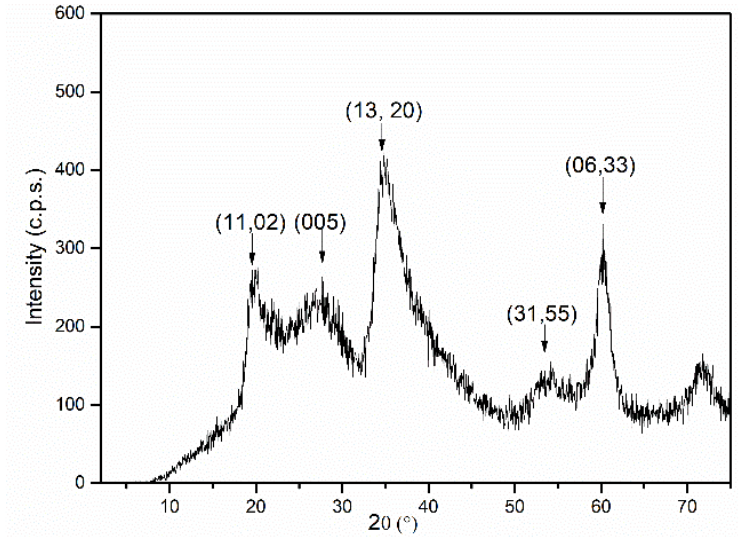
Figure 1. PXRD diagram of sample